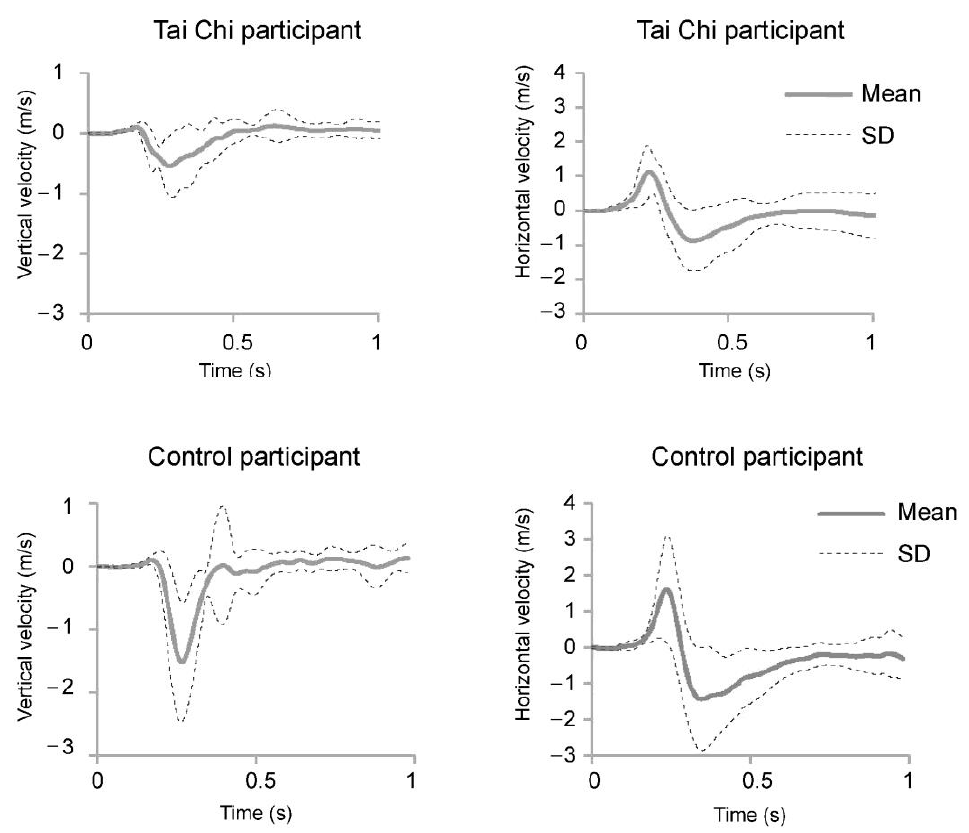
Figure 4. Example of vertical ( left ) and horizontal ( right ) knee velocity after hip perturbation. There were statistically significant main group effects for V y at the knee (F (1,18) = 10.438, p = 0.005), but not for shoulder or hip V y . ( p = 0.342). Post-hoc tests for knee V y showed statistically significant differences for shoulder (t = 2.512, p = 0.022, d = 2.05) and arm perturbations (t = 2.165, p = 0.047, d = 2.55) (Figure